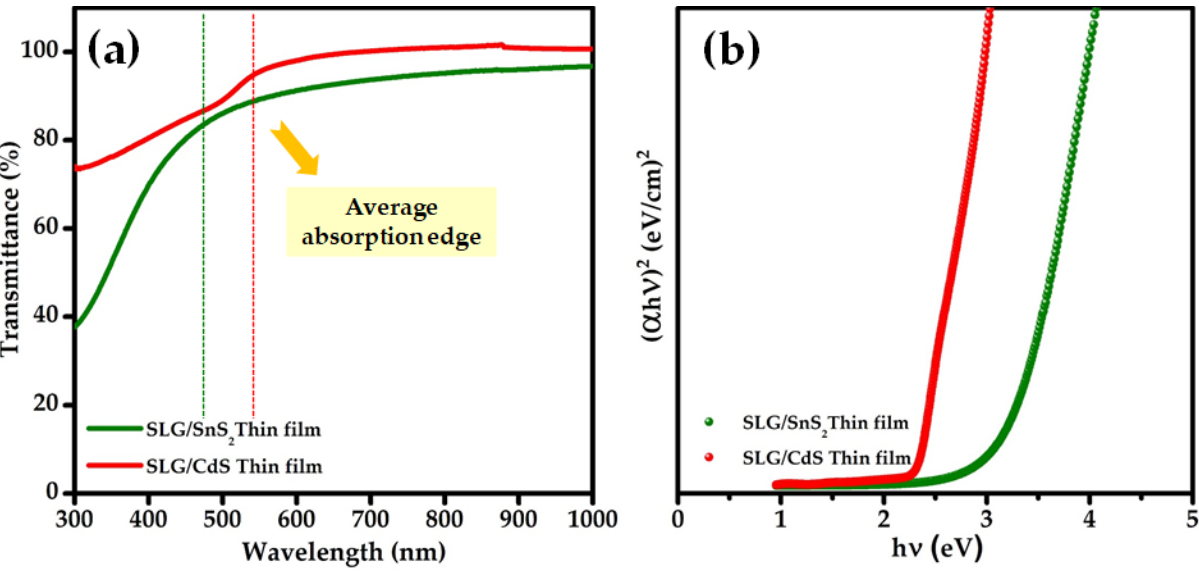
Figure 8. ( a ) Optical transmittance spectrum and ( b ) (αhυ) 2 vs. hυ plots of SnS 2 and CdS thin films.